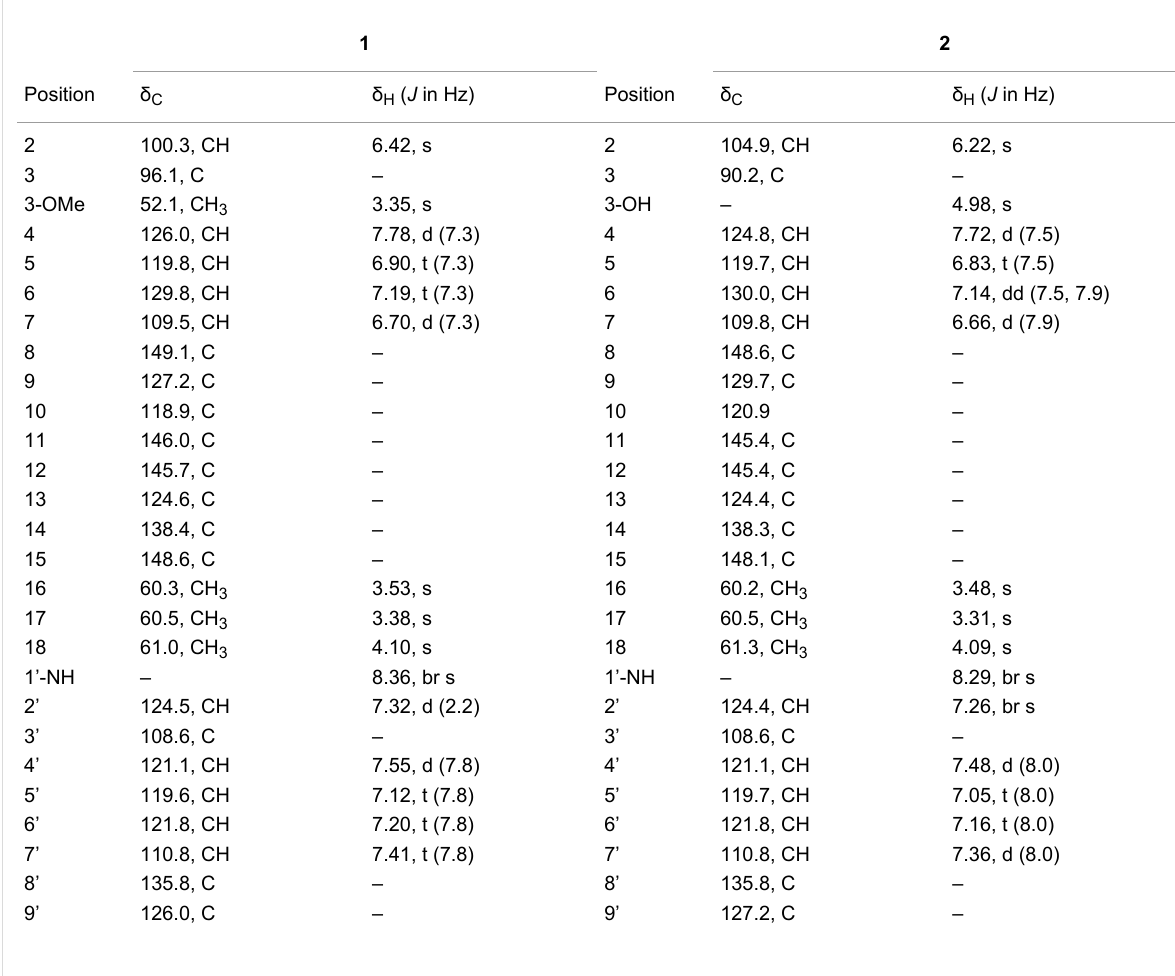
Table 1: 1 H and 13 C NMR data of compounds 1 and 2 (at 500 MHz for 1 H and 125 MHz for 13 C, measured in CDCl 3